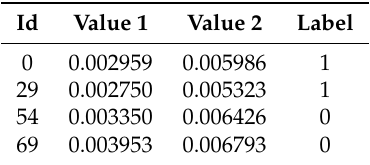
Table 6. Result of a regularization